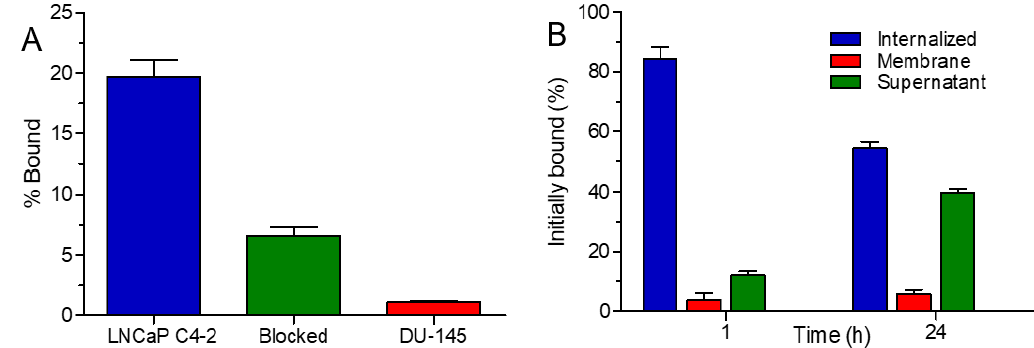
Figure 7. ( A ) The binding specificity of 131 I-D2B-PEG-silane-NaA to LNCaP C4-2 and DU145 cells without and in the presence of 25-fold molar excess of unlabeled D2B mAb (Blocked); ( B ) Different cellular fractions of 131 I-D2B-PEG-silane-NaA during receptor-mediated internalization into LNCaP C4-2 cells over 24 h at 37 °C.